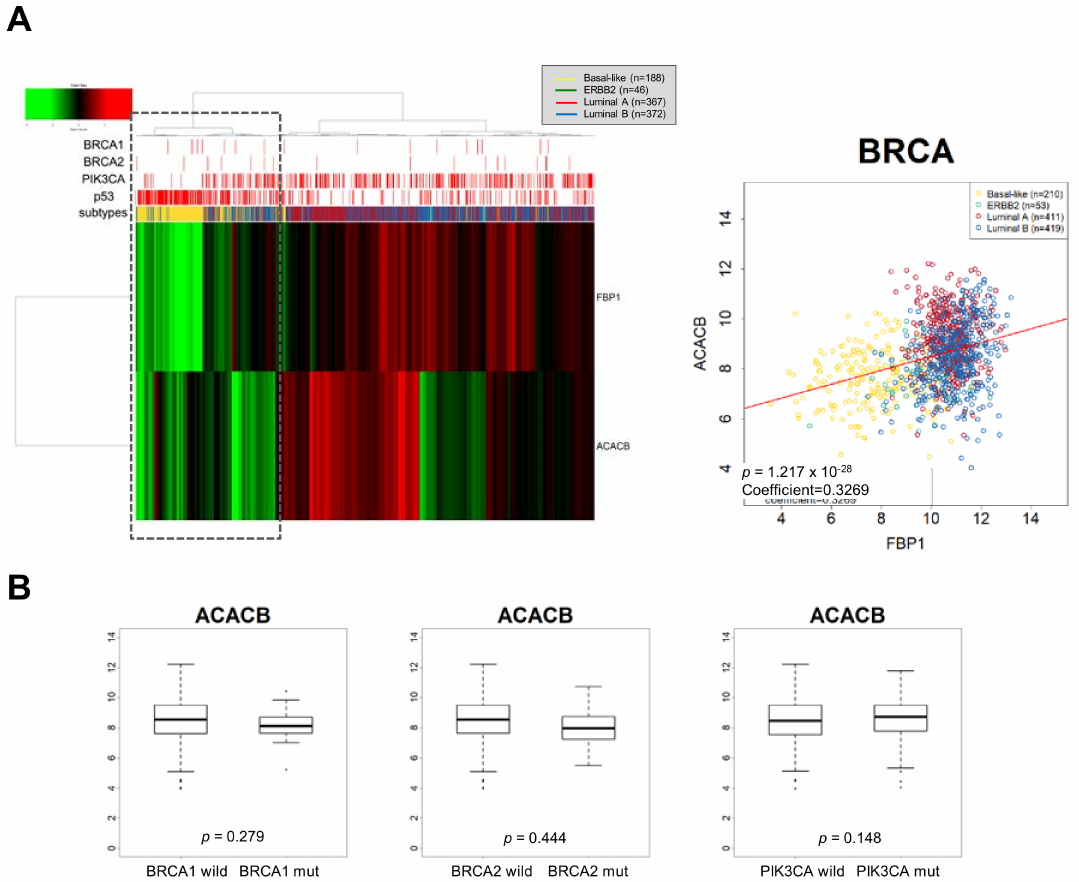
Figure 3. FBP-loss accompanies activation of FAO by down-regulation of ACC2 in basal-like subtype. ( A ) Unsupervised hierarchical cluster analysis of breast cancer patient samples in The Cancer Genome Atlas (TCGA) using FBP1 and ACC2 (ACACB) to discriminate between metabolic subsets of tumors with breast cancer subtypes (left panel). FBP1 and ACC2 were simultaneously suppressed in basal-like subtype having p53 mutation (dot lined box). Pearson distance analysis with a positive distance correlation of FBP1 and ACC2 (right panel, coe ffi cient = − 0.327, p < 0.001). ( B ) ACC2 transcript abundance according to the BRCA1 / 2 or PIK3CA mutation in breast cancer samples.